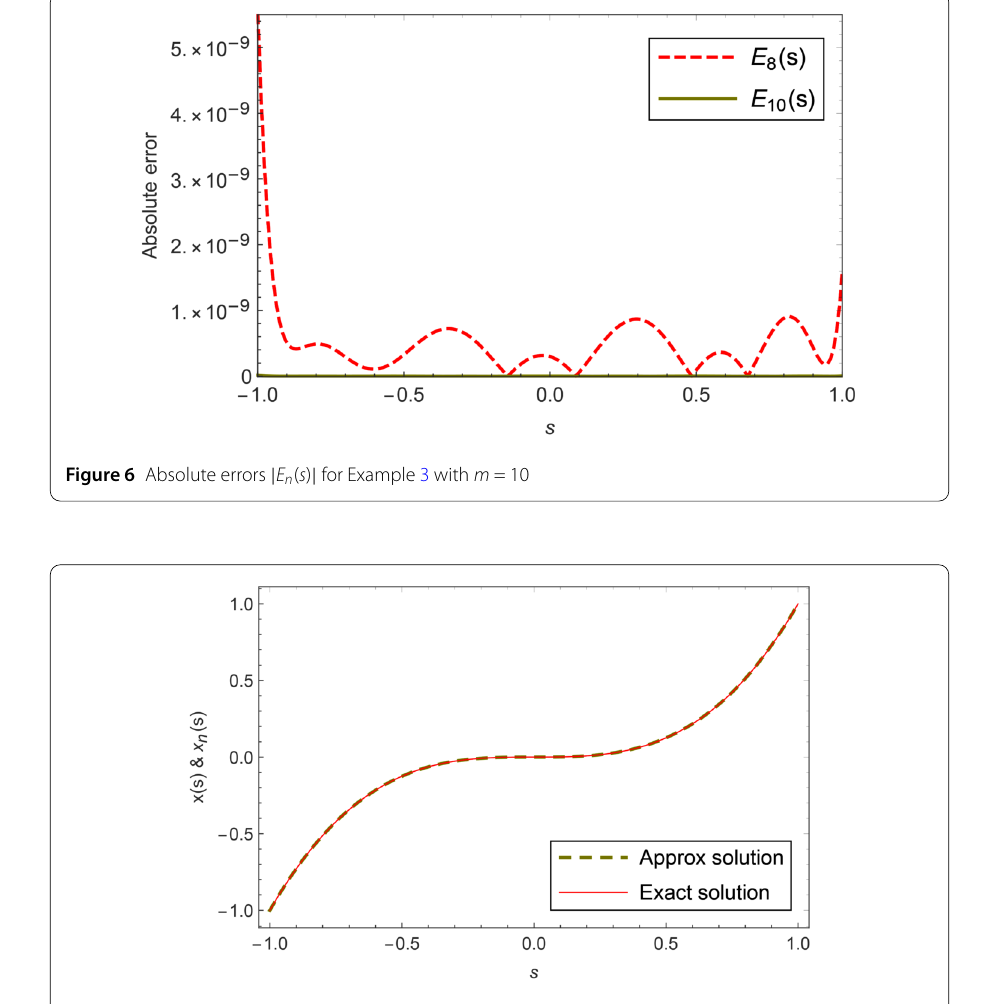
Figure 7 Comparison of solutions for Example 4 with n = 7 and m = 5